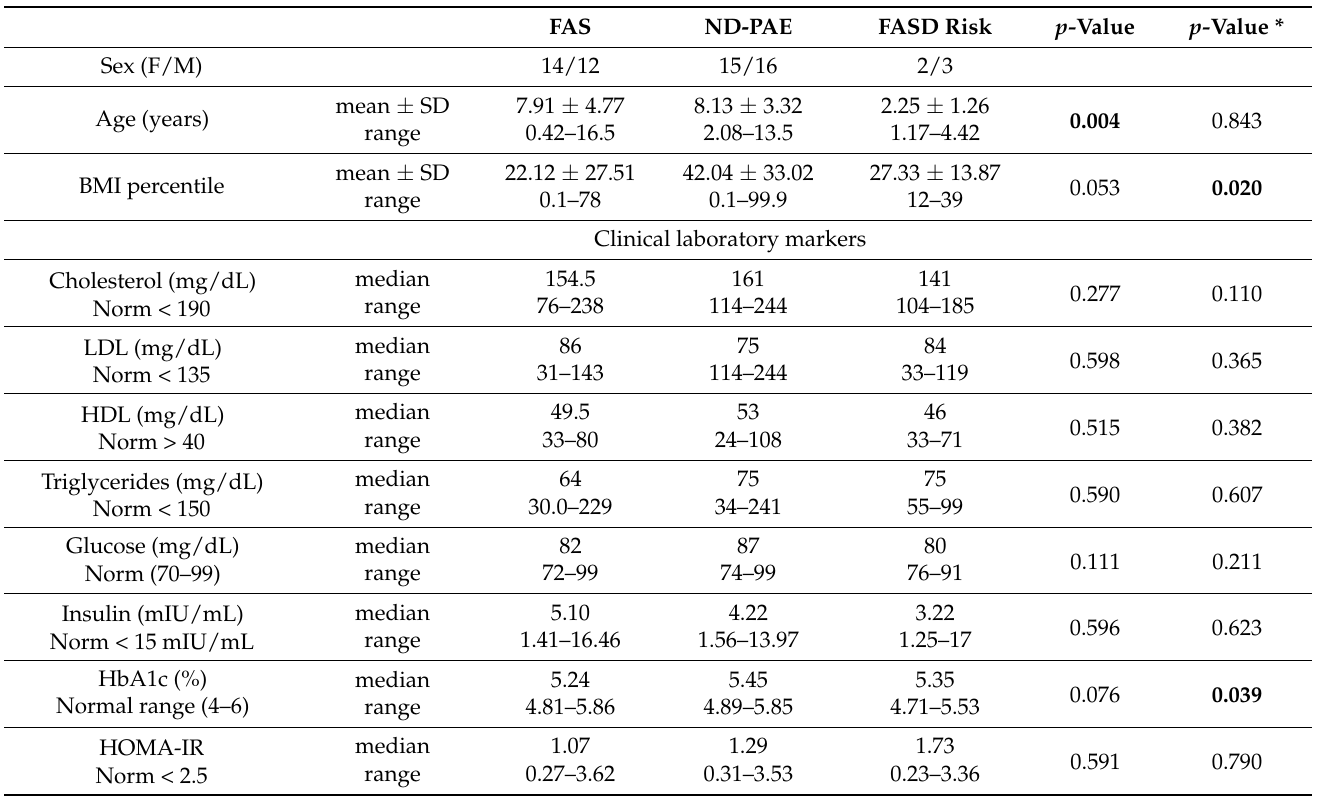
Table 2. Baseline demographic and clinical data of FASD